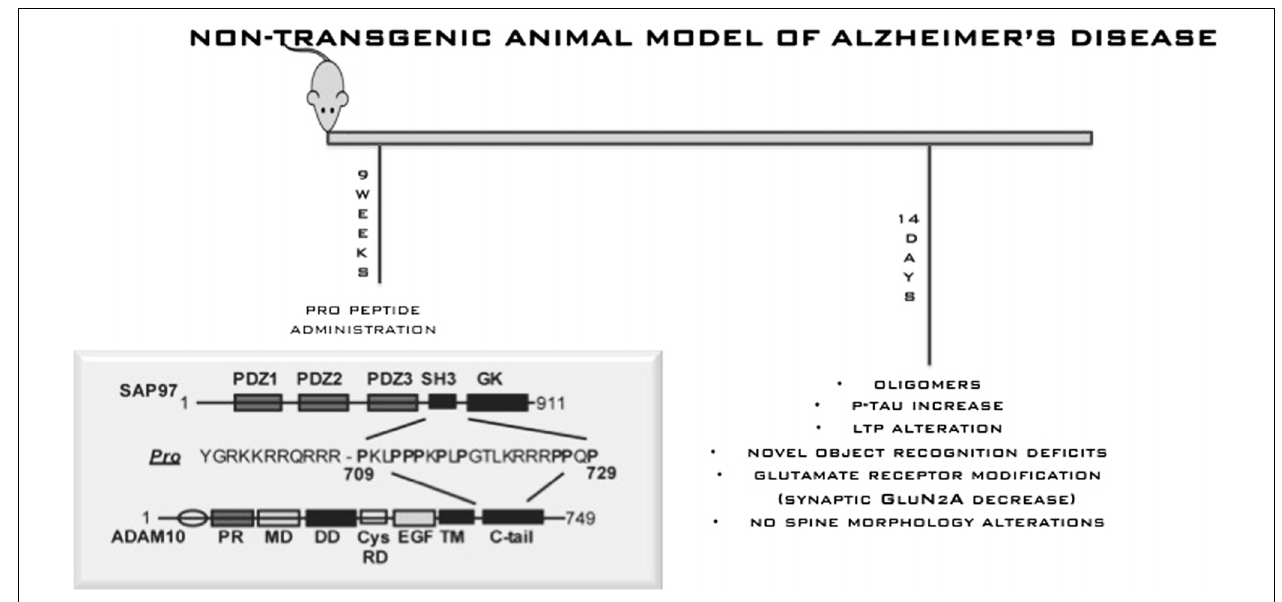
FIGURE 5 | Non-transgenic animal model forAD. This model mimics early stages of sporadic disease, which represents the vast majority of cases.The model was obtained by interfering with the complex ADAM10/SAP97 for